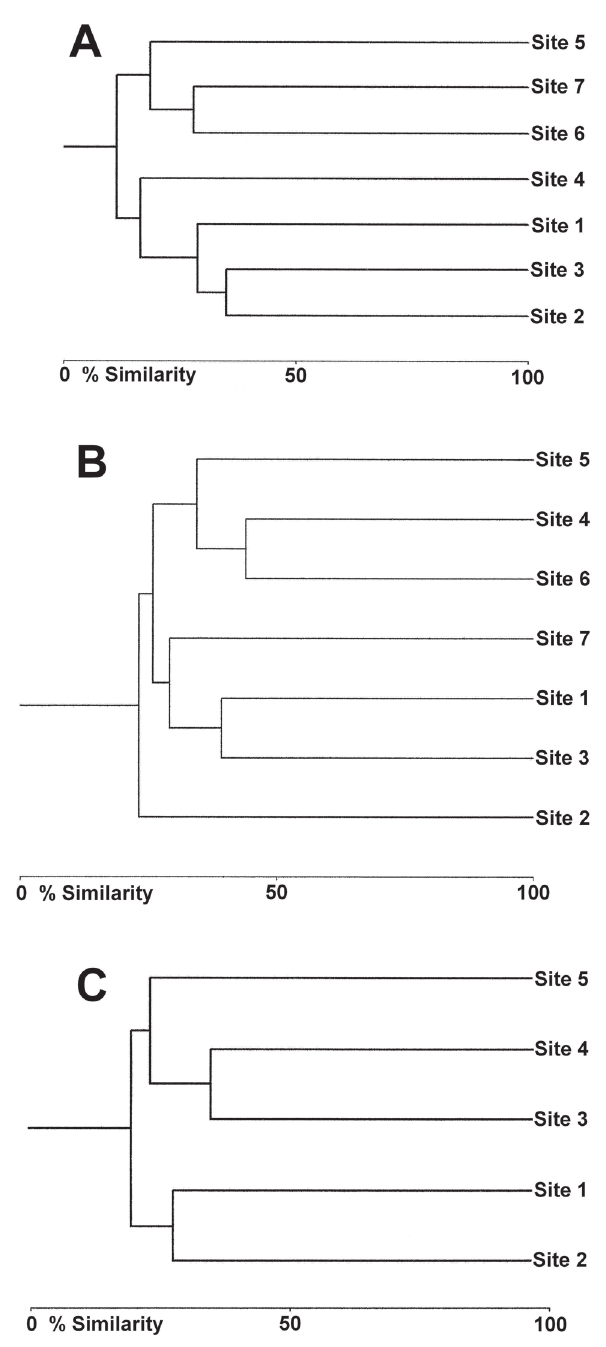
Fig. 3. Cluster analysis based on Jaccard distance (UPGMA method) of fish assemblages in the seven floodplain lakes. A. March 1999 (after a long lasting inundation phase of the Paraná River), B-September 1999 (at receding water) and C- February 2000 (during